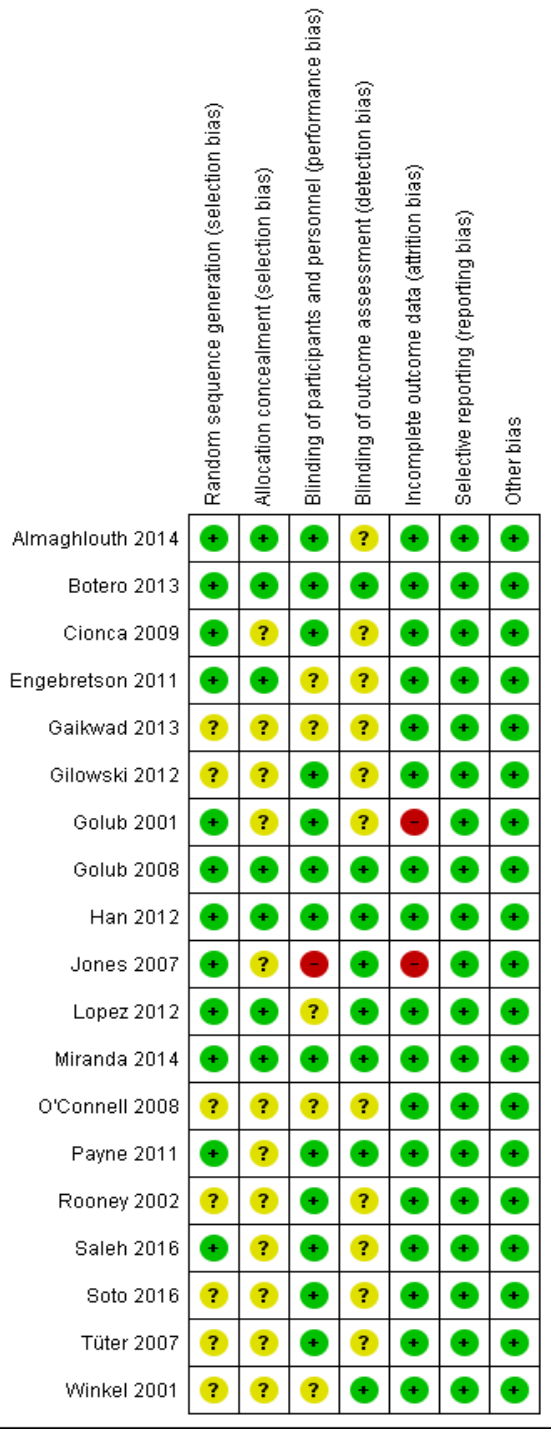
Figure 2. Risk of bias graph for studies assessing mechanical debridement with antibiotics in the treatment of periodontitis.